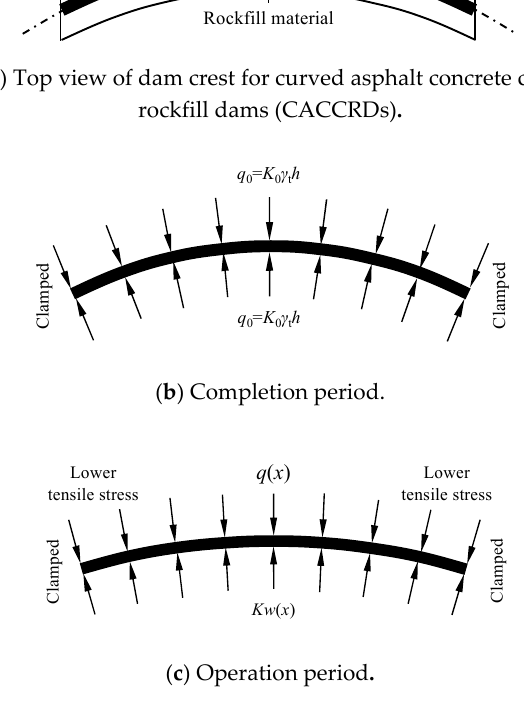
Figure 17. Mechanical diagram of curved asphalt concrete core (CACC) (completion period and operation period).